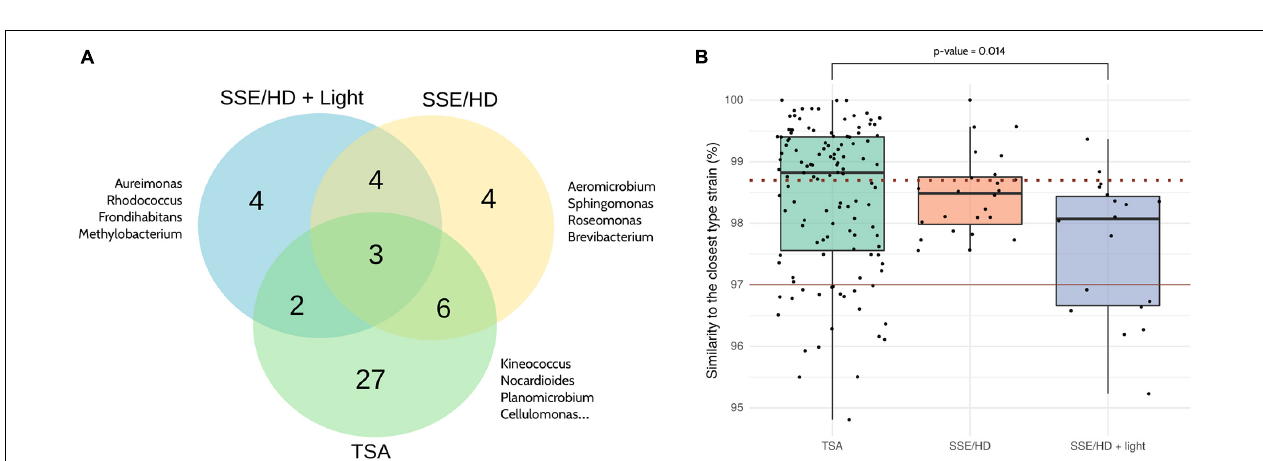
FIGURE 5 | Summary of the strains isolated from the selected samples (X1.1, X2.1, and C1). (A) Number of different strains, genera and desiccation-/ radiation- resistant genera isolated from each sample. (B) Venn diagram comparing the desiccation- and radiation-resistant genera isolated from any replicate of each selected sample. Note that all the identifications were obtained by partial 16S rRNA gene Sanger sequencing.